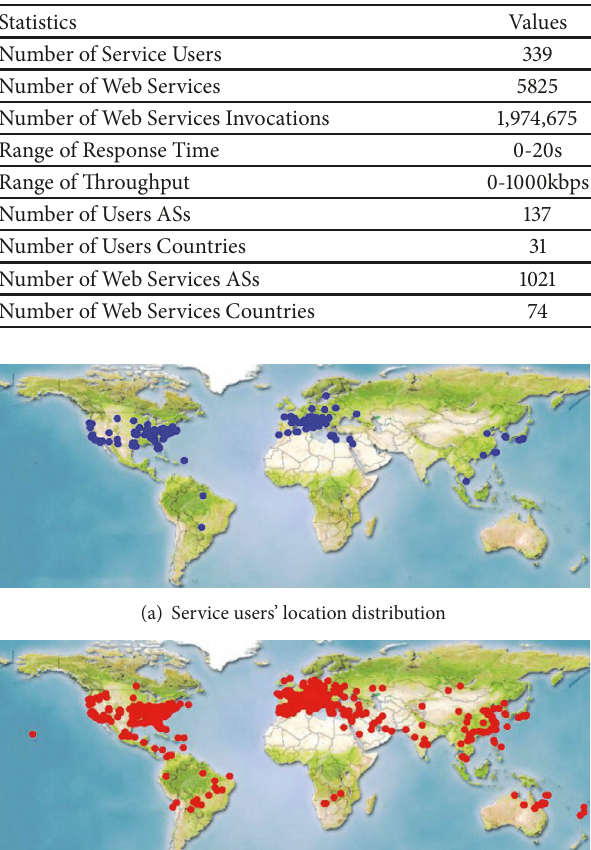
Table 6: Statistics of Web service QoS dataset.